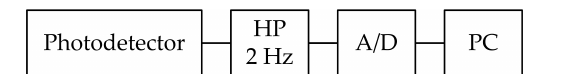
Figure 2. A simplified block diagram of the evaluation unit (detection part). HP,